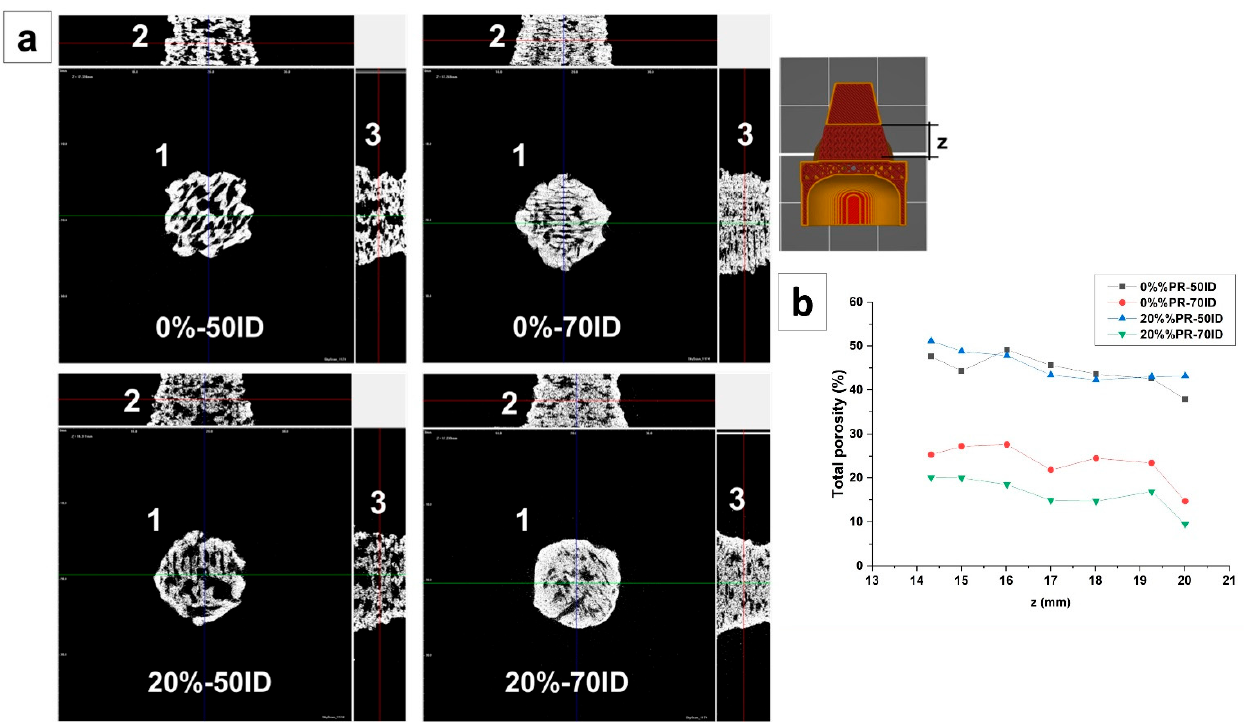
Figure 7. ( a ) Axonometric projection images analyzed with X-ray tomography. ( b ) Total porosity, measured along the permeable part of the prototype.